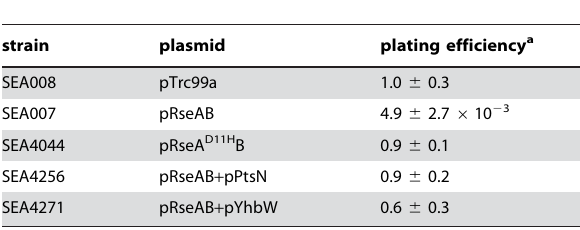
Table 1. Plating efficiencies following inhibition of s E